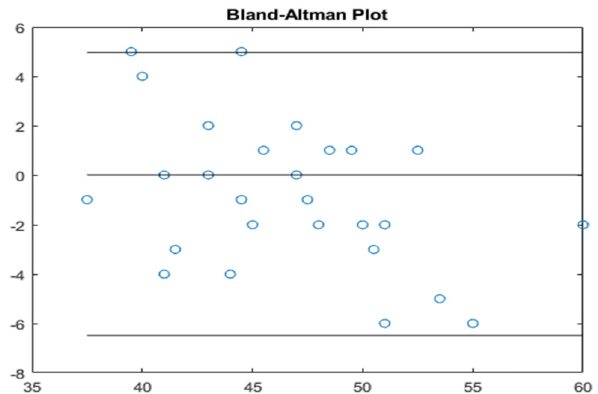
Figure 24: Bland – Altman scatter plot for the polymegathism